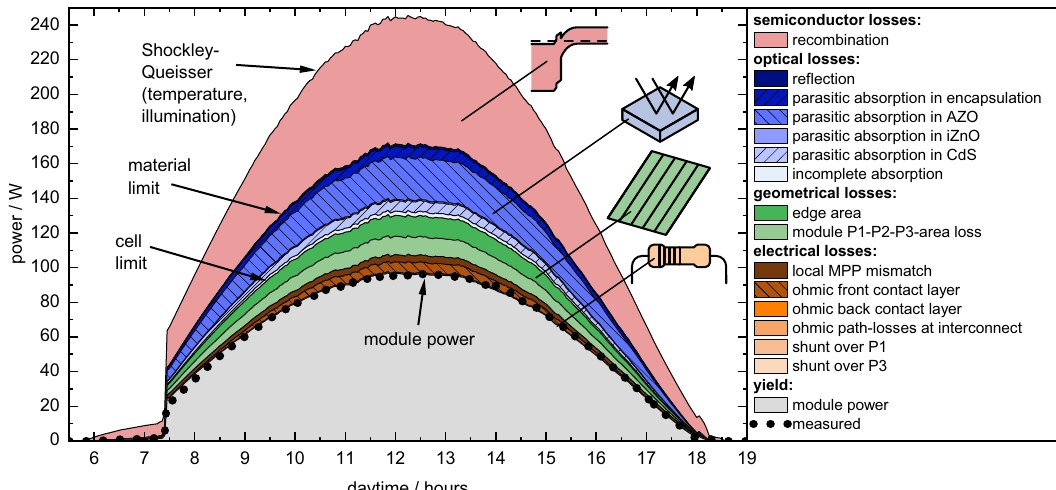
Fig. 6 Shockley – Queisser model, loss analysis and generated module power during daytime of September 9, 2020. The material abbreviations CdS, i:ZnO, and AZO stand for cadmium sul fi de, intrinsic zinc oxide, and aluminum-doped zinc oxide, respectively, MPP is the maximum power point, and P1, P2, and P3 are the interconnecting trenches between to serially connected cells. The upper edge of the red area represents the Shockley-Queisser limit for a band gap of 1.13 eV adapted for the module size and the prevailing illumination and temperature. After all losses are identi fi ed and quanti fi ed, the module is predicted to produce the power indicated within the gray area. Actual measurements in the fi eld are marked as black